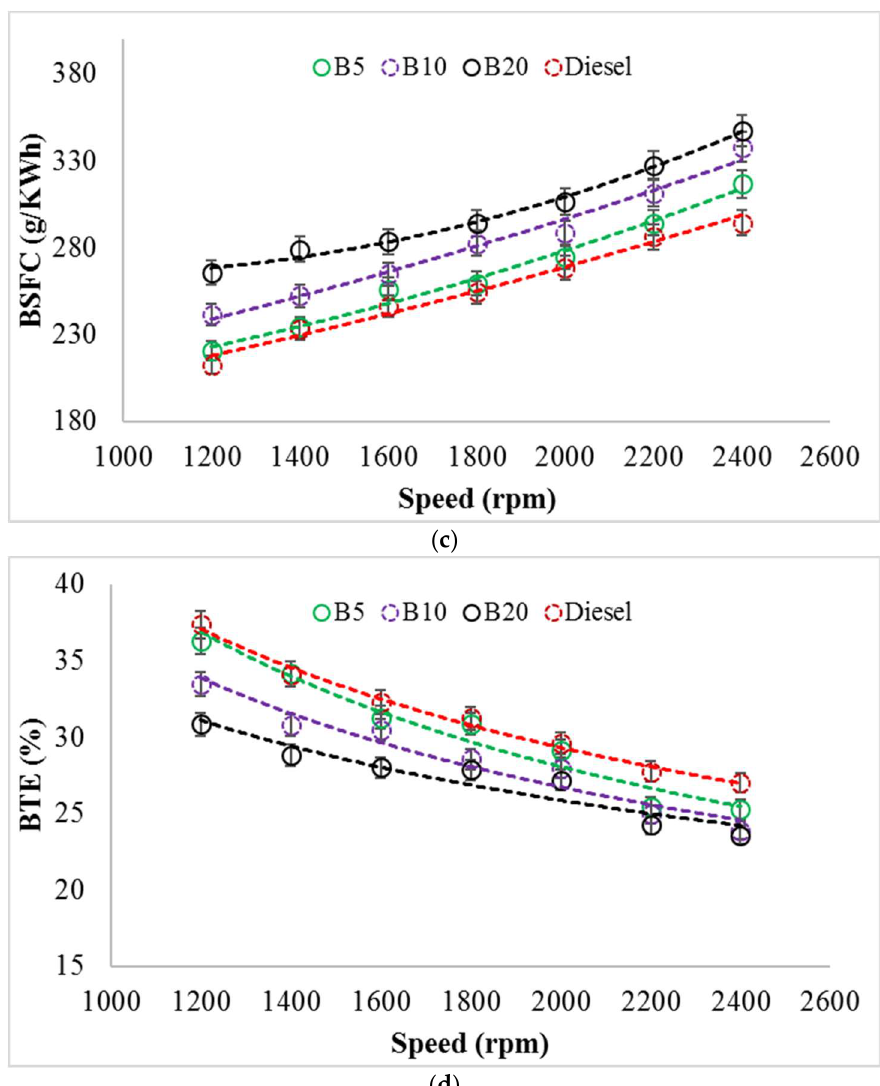
Figure 5. Variation of: ( a ) brake power, ( b ) torque, ( c ) brake specific fuel consumption (BSFC), and ( d ) brake thermal efficiency (BTE) for all PSO biodiesel-diesel blends and diesel with respect to engine speed at full load condition.